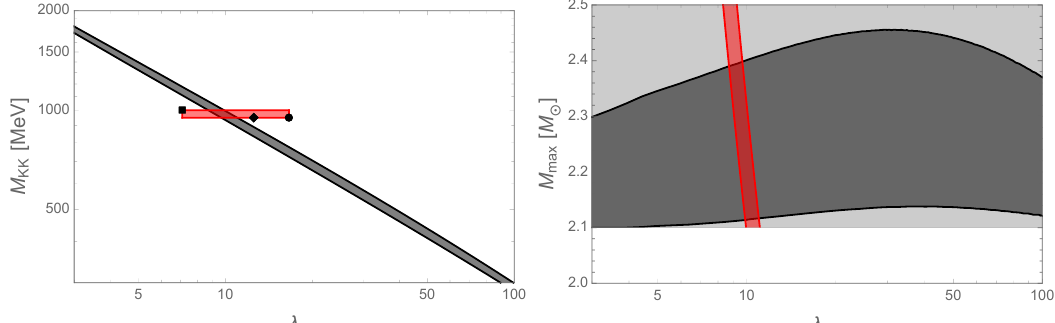
Figure 4: Left panel: Allowed range according to the astrophysical constraints in the λ - M plane (doubly logarithmic), obtained by applying the construction of Fig. 3 KK for each λ . The three symbols mark the parameter pairs from the QCD fits of table 1, and we use them to define a "QCD window" (red). Right panel: Constraints for the maximal mass of the neutron star as a function of the ’t Hooft coupling λ . The light gray band gives the constraint from astrophysical data. The dark gray band and the red band arise from applying the constraints of the left panel.